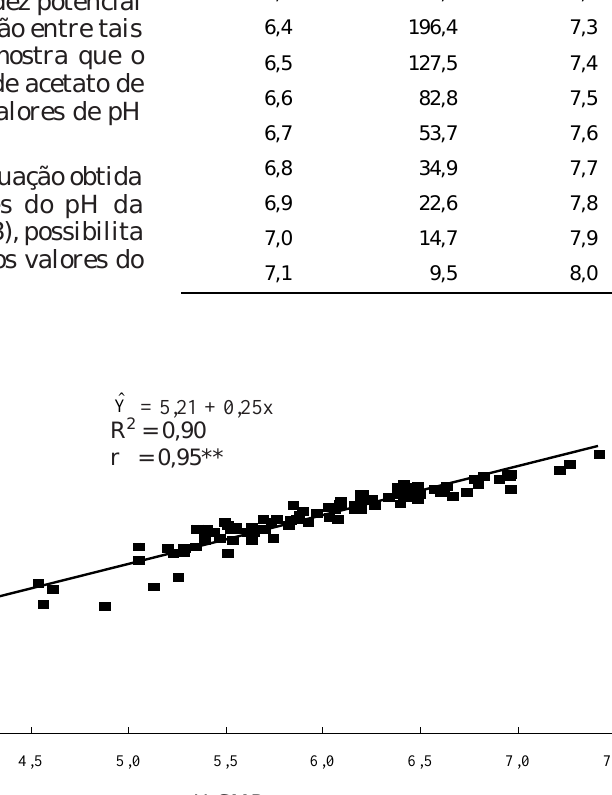
Pela análise da correlação curvilinear simples entre a acidez potencial e o pH da suspensão de acetato de cálcio 0,5 mol L -1 (R = 0,82**), pode-se inferir